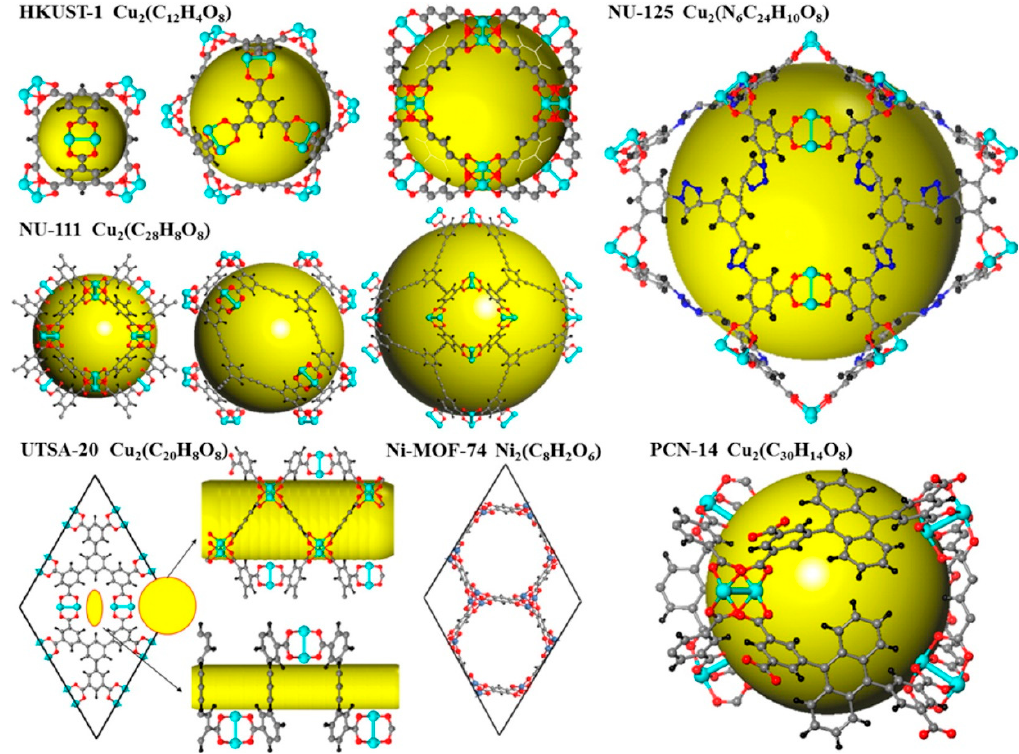
Figure 9. Nanocages of NU-111, Ni-MOF-74, PCN-14, UTSA-20, HKUST-1, and NU-125 and their empirical formulas. Carbon atoms are shown in gray, hydrogen atoms are shown as black spheres, oxygen atoms are shown as red spheres, copper atoms are shown as cyan spheres, and nitrogen atoms are shown as blue spheres. Adapted with permission from Ref. [70]. Copyright 2013 American Chemical Society.